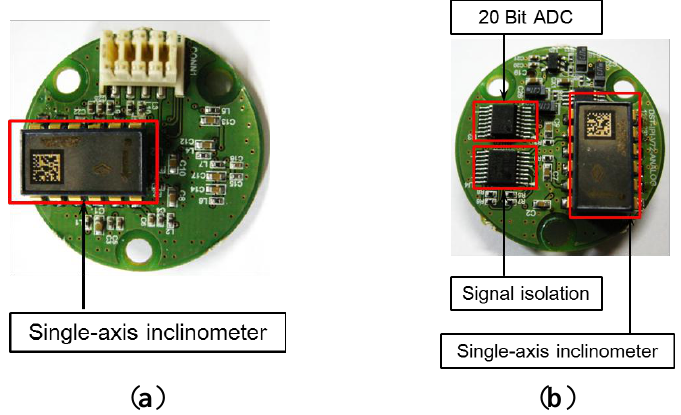
Figure 4. Tilt sensor module. ( a ) Upper surface; ( b ) Lower